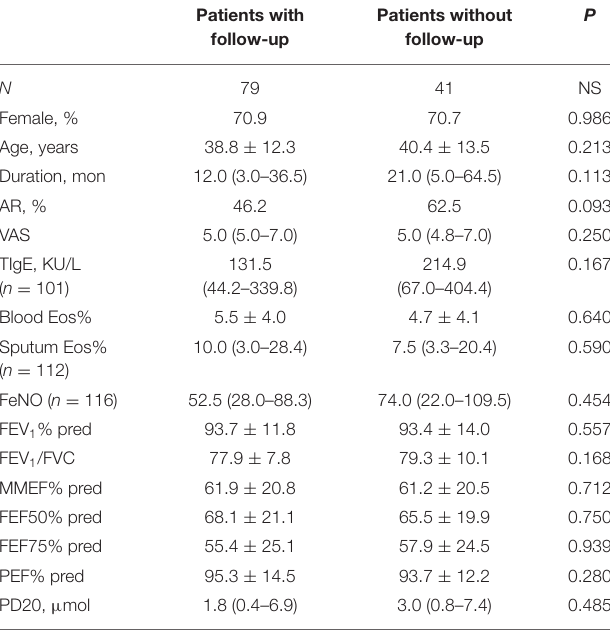
TABLE 4 | Demographics and baseline clinical characterization between patients with follow-up and patients without follow-up. Patients with Patients without follow-up